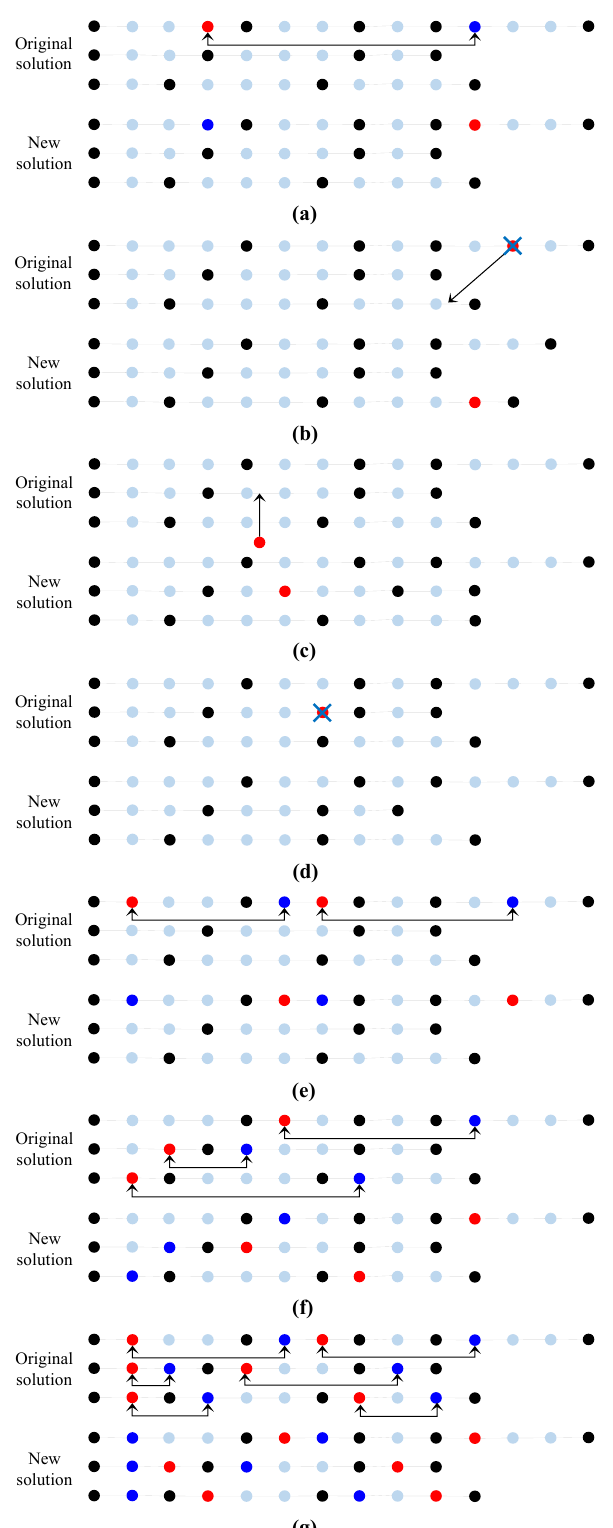
Figure 3. Illustration of the creation of a new delivery routing sequence using seven